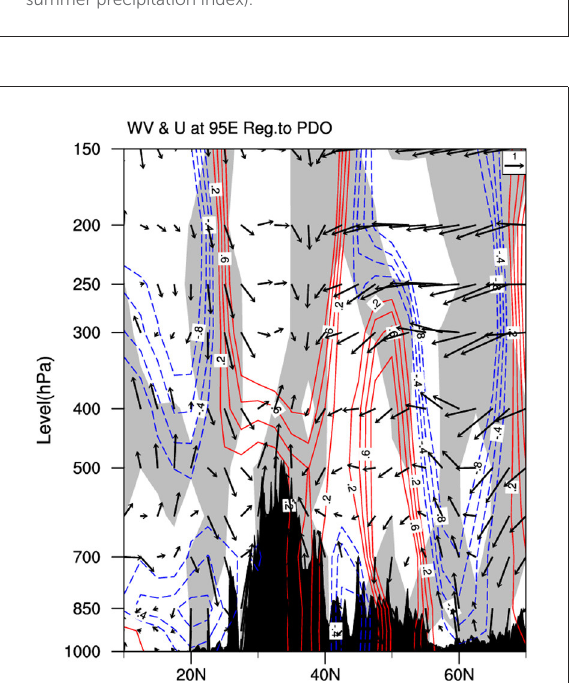
FIGURE7 Summer SST anomaly distribution (A) 1989–1998; (B) 1999–2010; (C) the difference between 1989–1998 and 1999–2010. Dotted area indicates significance at the 95% confidence level (Shang et al., 2019).